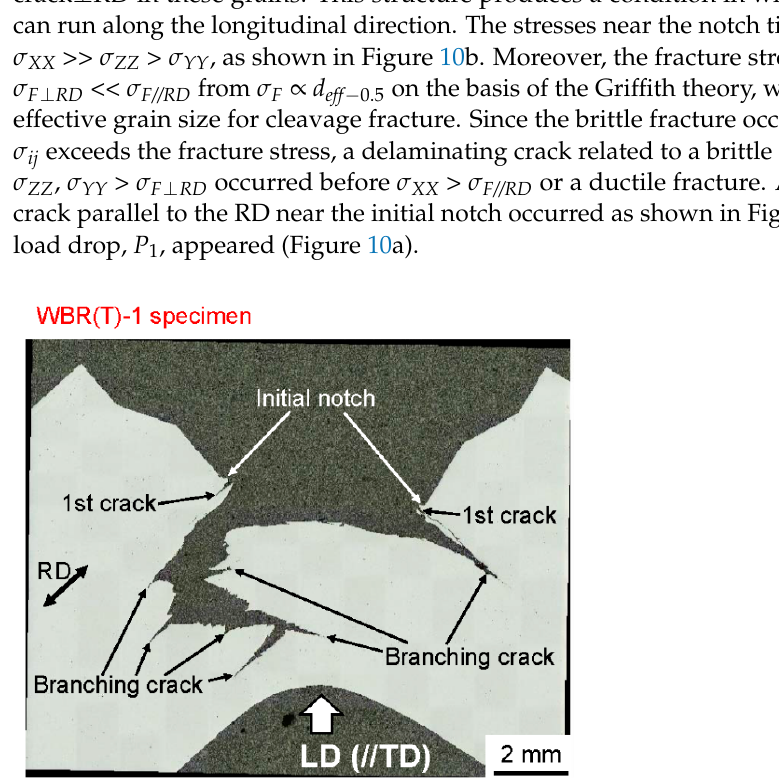
Figure 11. Cross-sectional image of the WBR(T)-1 specimen after the bending test.